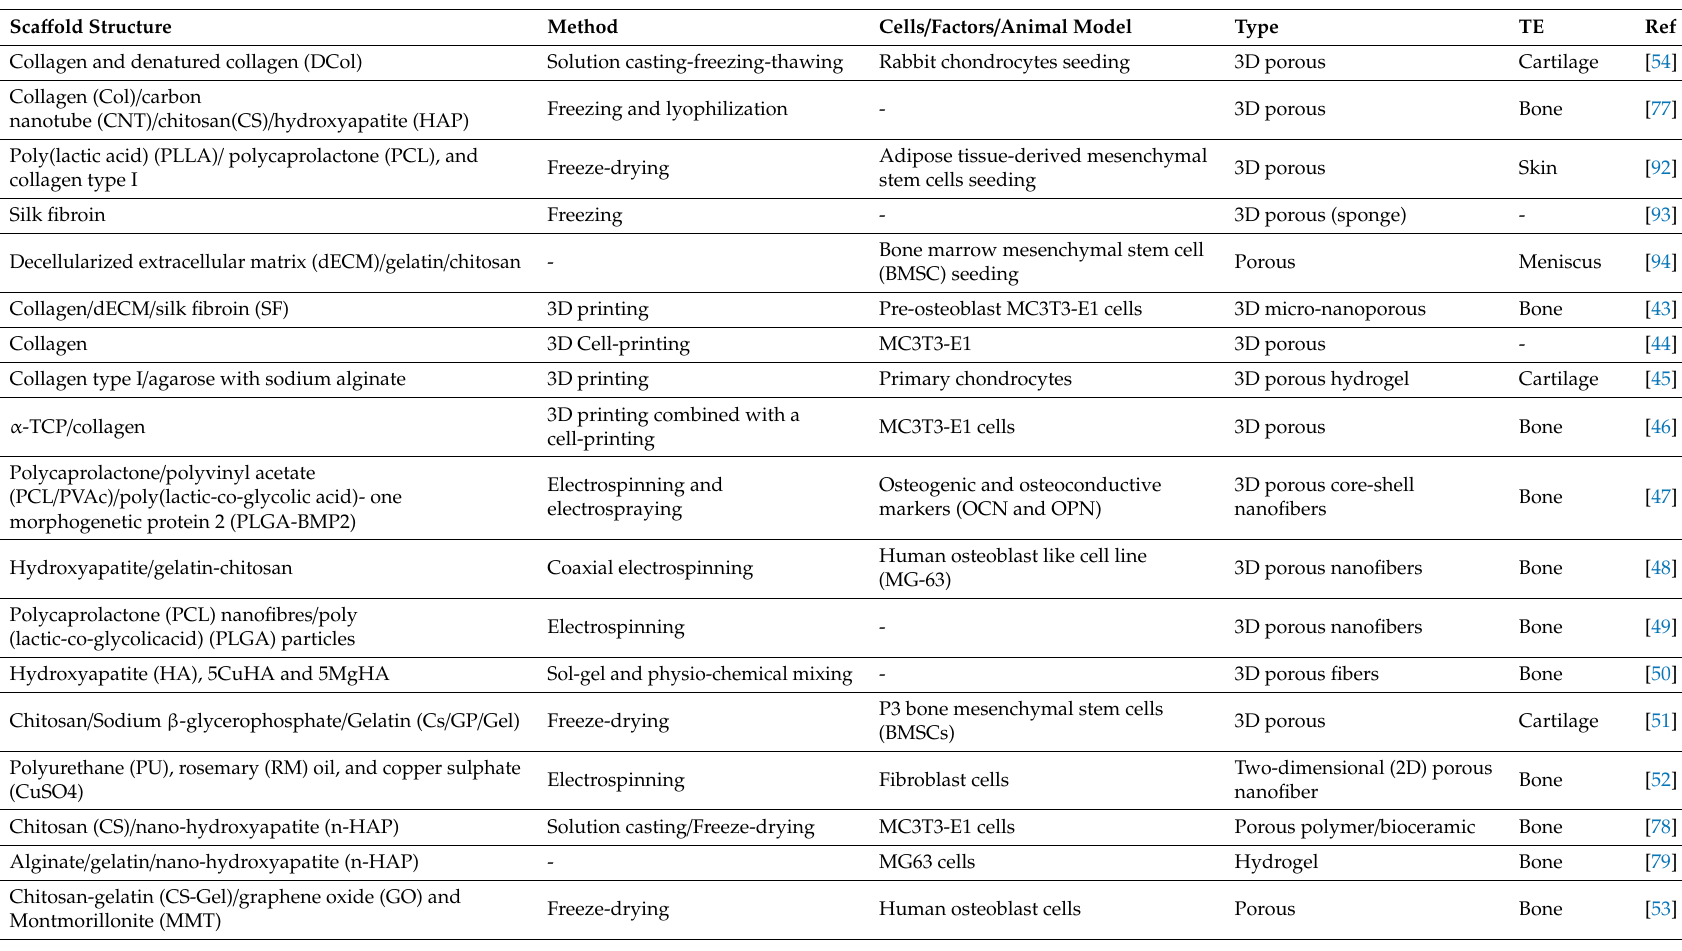
Table 3. The most recent cellular and acellular reported studies using various forms of sca ff olds for tissue engineering (TE)